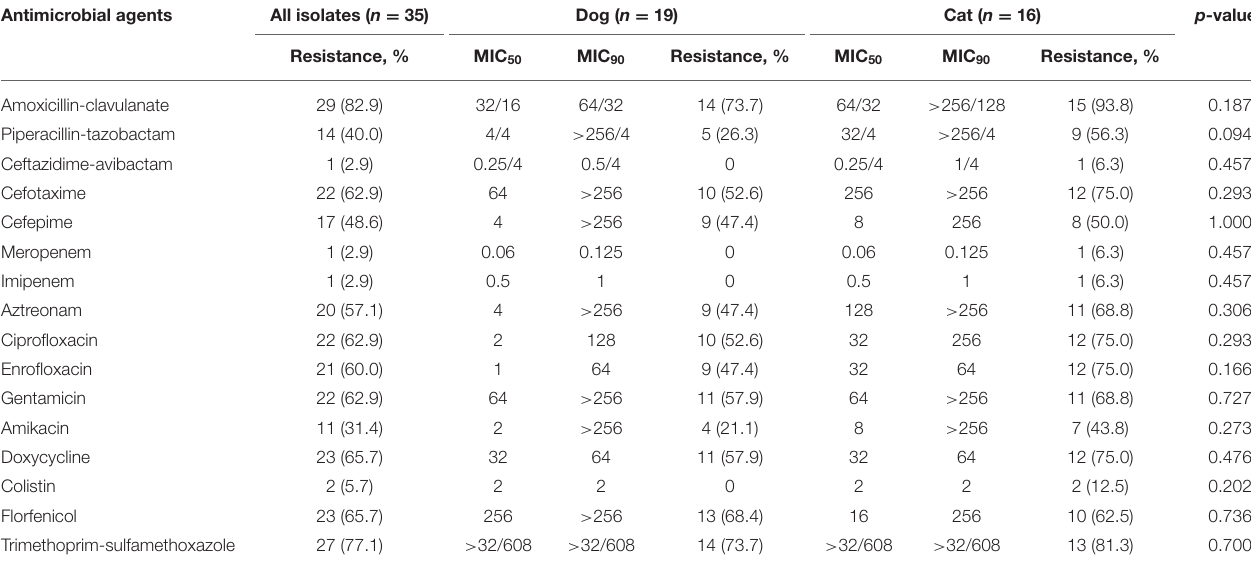
TABLE 2 | Antimicrobial resistance of clinical K. pneumoniae complex isolates from dogs and cats. Antimicrobial agents All isolates ( n = 35)